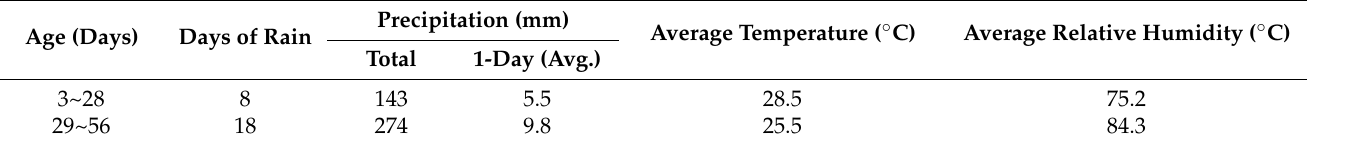
Table 4. Information on natural environment.